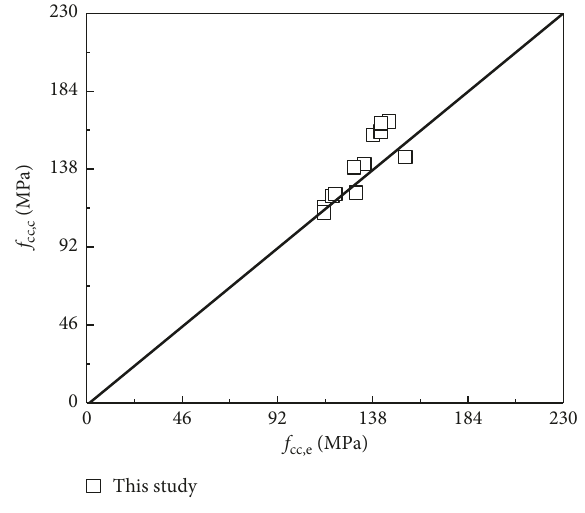
Figure 10: Comparison between test results and Mander’s model.